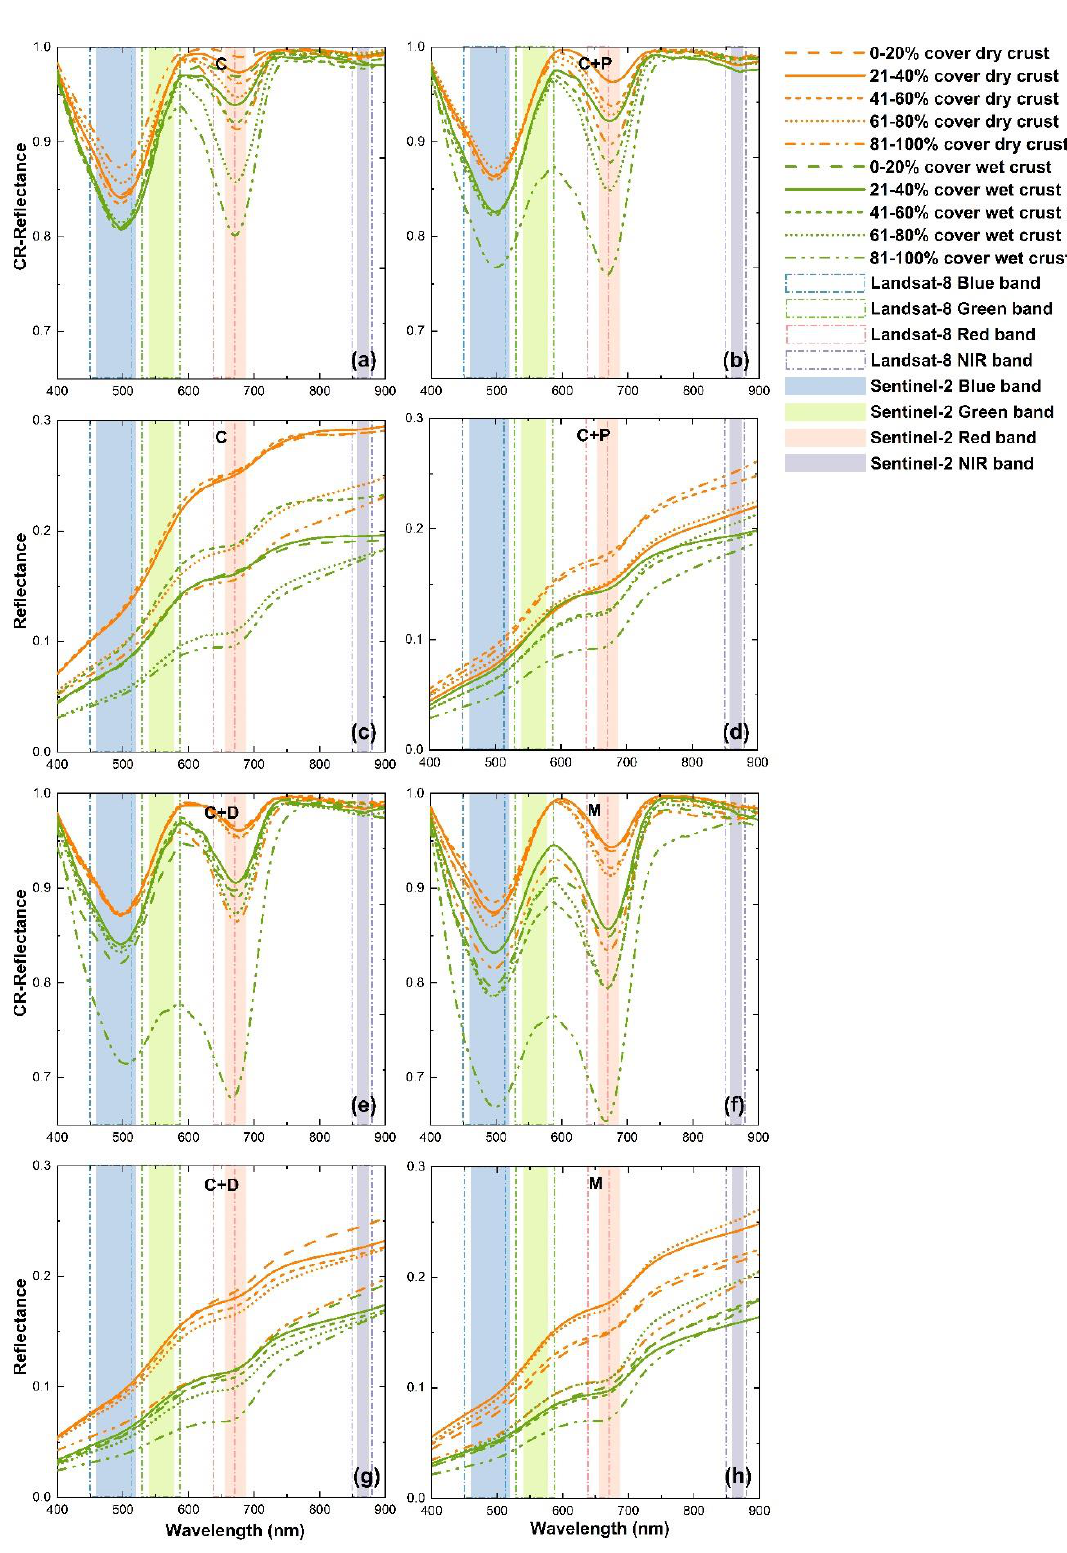
Figure 6. Spectral reflectance and reflectance after continuum removal (CR) processing of different cover types within different BSC coverage ranges in dry and wet conditions. ( c , d , g , h ) Spectral reflectance at 400–900 nm. ( a , b , e , f ) Spectral reflectance after continuum removal at 400–900 nm.